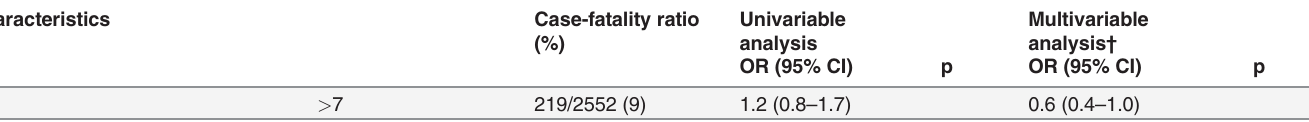
OR — Odds ratio, CI — con fi dence interval, HIV — human immunode fi ciency virus, CHBAH — Chris Hani Baragwanath Academic